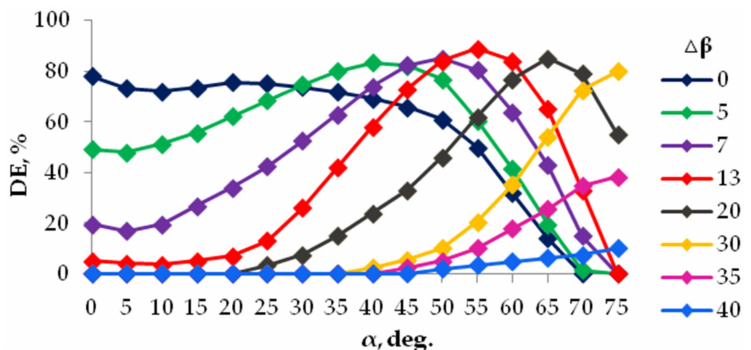
Figure 4. Dependence of diffraction efficiency of volume gratings in Bayfol HX material on angles α and β , obtained using Scheme